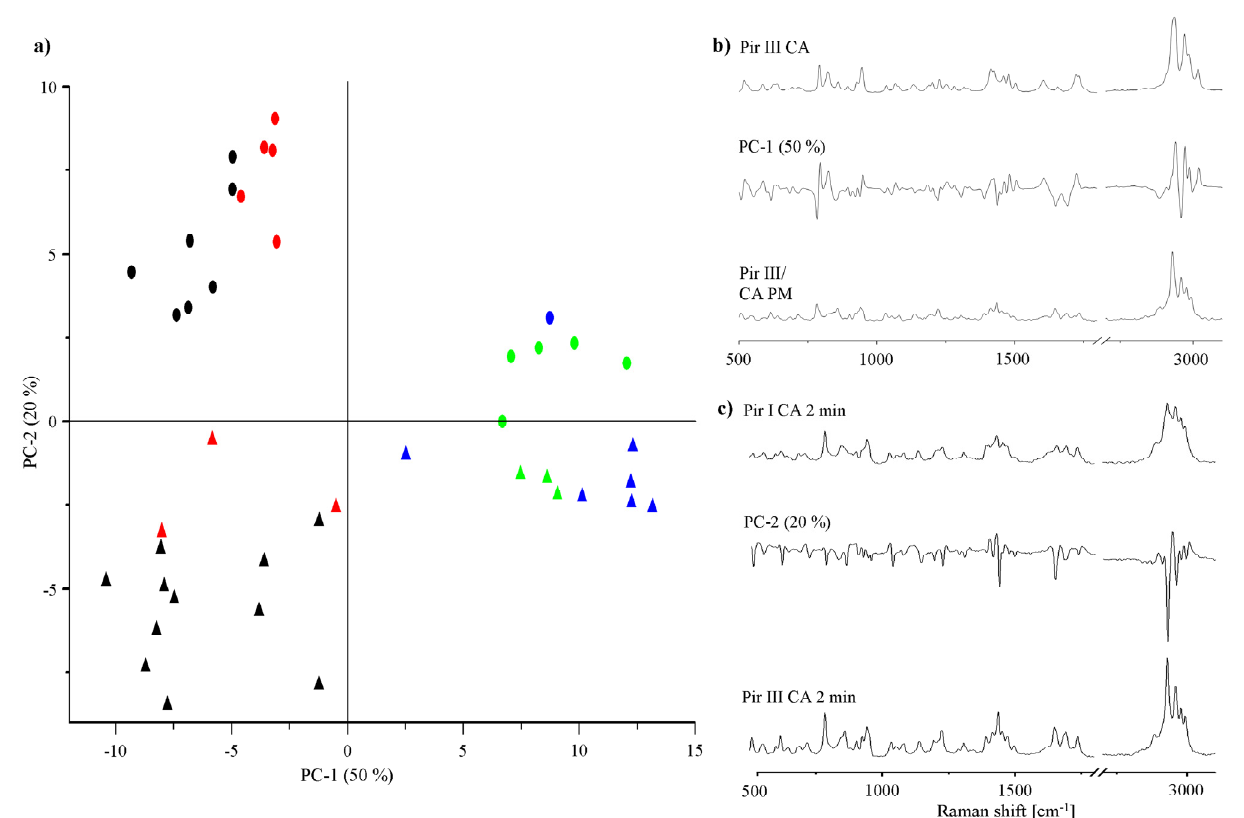
Figure 10. ( a ) PCA 2D score plot of piracetam form I (circles) or form III (triangles) dry-ground with citric acid. Black symbols represent non-cocrystal systems ground for less than 5 min, blue symbols represent cocrystal systems, red symbols represent samples being X-ray amorphous after various grinding times, green symbols represent the amorphous samples after crystallization, forming the cocrystal. ( b ) Loadings plot of PC-1. ( c ) Loadings plot of